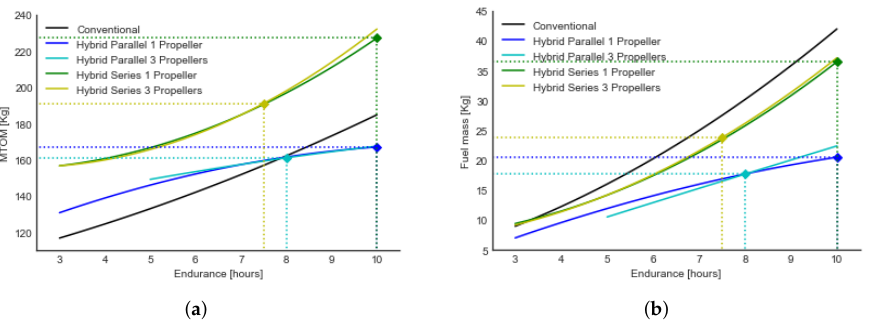
Figure 11. Comparison between series, parallel hybrid, and conventional propulsion configurations 2000 m. ( a ) MTOM vs. Endurance; ( b ) Fuel Mass vs. Endurance.